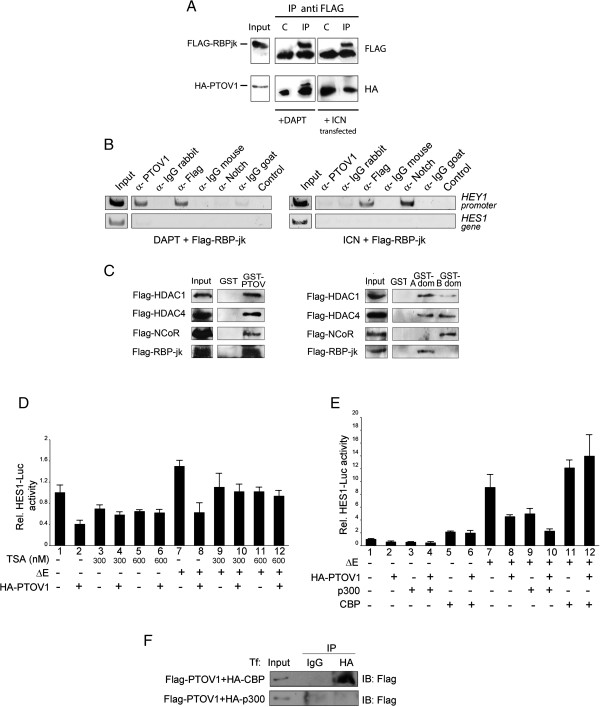
PTOV1 interacts with RBP-Jκ and the Notch repressor complex at the HEY1 promoter and its repressive function requires HDACs activity and it is restrained by CBP. (A) PTOV1 interacts with RBP-Jκ. PC-3 cells, transfected with FLAG-RBP-Jκ and HA-PTOV1, were co-transfected with ICN or treated with DAPT for 4 days. Cell lysates were immunoprecipitated with FLAG antibody or control IgG and blots were revealed with anti-HA antibody. (B) Endogenous PTOV1 occupies the endogenous HEY1 promoter under conditions of Notch signaling inhibition. PC-3 cells, transfected with FLAG-RBP-Jκ, were treated with DAPT (left) or co-transfected with ICN (right). Chromatin was immunoprecipitated with antibodies to PTOV1, FLAG, Notch1, or non-specific IgGs. Associated DNA fragments were analyzed by PCR with primers specific for HEY1 promoter regions. Primers from intragenic regions of the HES1 gene were used as a specificity control. (C) PTOV1 interacts with the Notch repressor complex. FLAG-HDAC1, FLAG-HDAC4, FLAG-NCoR and FLAG-RBP-Jκ were separately transfected into PC-3 cells and tested for interaction with GST-PTOV1 (left panel) or GST-A domain, GST-B domain (right panel) or control GST beads. Bound proteins were analyzed by Western blotting with anti-FLAG. (D) PTOV1 repressor activity requires HDACs activity. Cells, transfected with HES1-luciferase, Renilla and the plasmids indicated, were treated with the HDAC inhibitor trichostatin A (TSA) for 48 h. Lysates were used in transactivation assays for firefly luciferase activity (E) Overexpression of the CBP acetyl-transferase, but not p300, overcomes the repressor activity of PTOV1 on the HES1 promoter. Cells, transfected with p300 or CBP plus the indicated plasmids, were used in HES1-driven luciferase transactivation assays. (F) PTOV1 interacts with CBP but not with p300. Lysates from cells transfected with FLAG -PTOV1 and HA-CBP (top), or HA-p300 (bottom), were immunoprecipitated with antibody to HA, or control IgG, and analyzed by Western blotting.